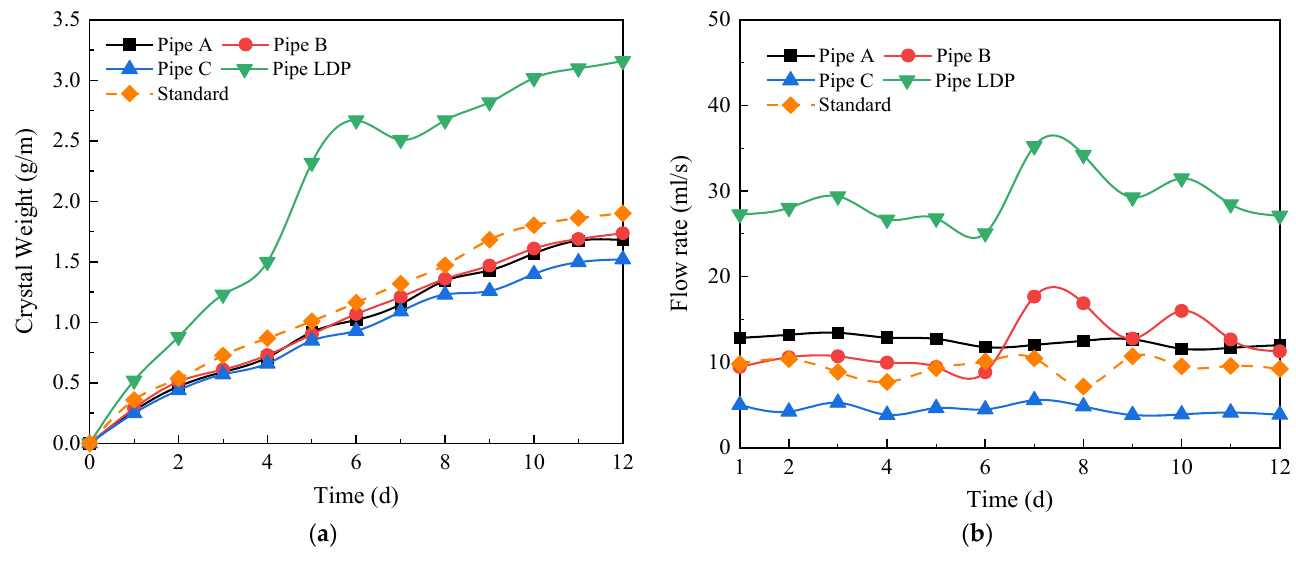
Figure 12. Variation of crystallization rate and flow rates of drainage pipes with time under different conditions. ( a ) Crystallization rate curves. ( b ) Flow rate curves.